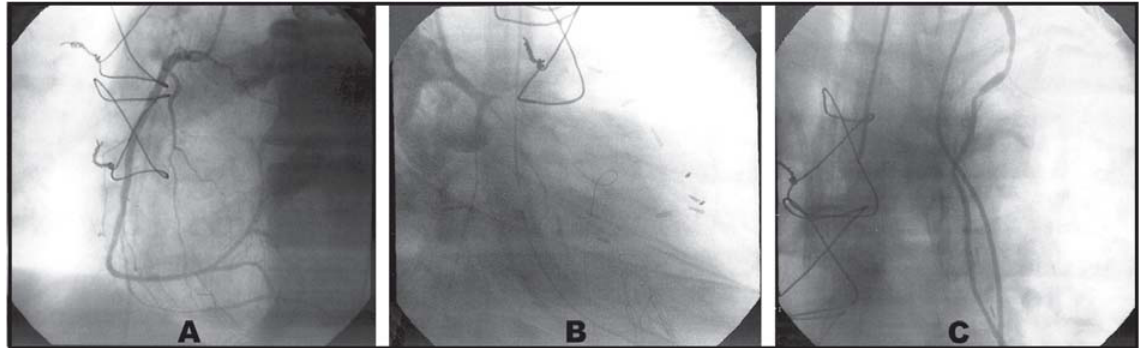
Fig. 4 - Demonstração angiográfica da artéria coronária direita e espasmo de toda a extensão da artéria coronária esquerda e seus ramos (A) e da artéria torácica interna esquerda e anastomose entre ATIE e AIA